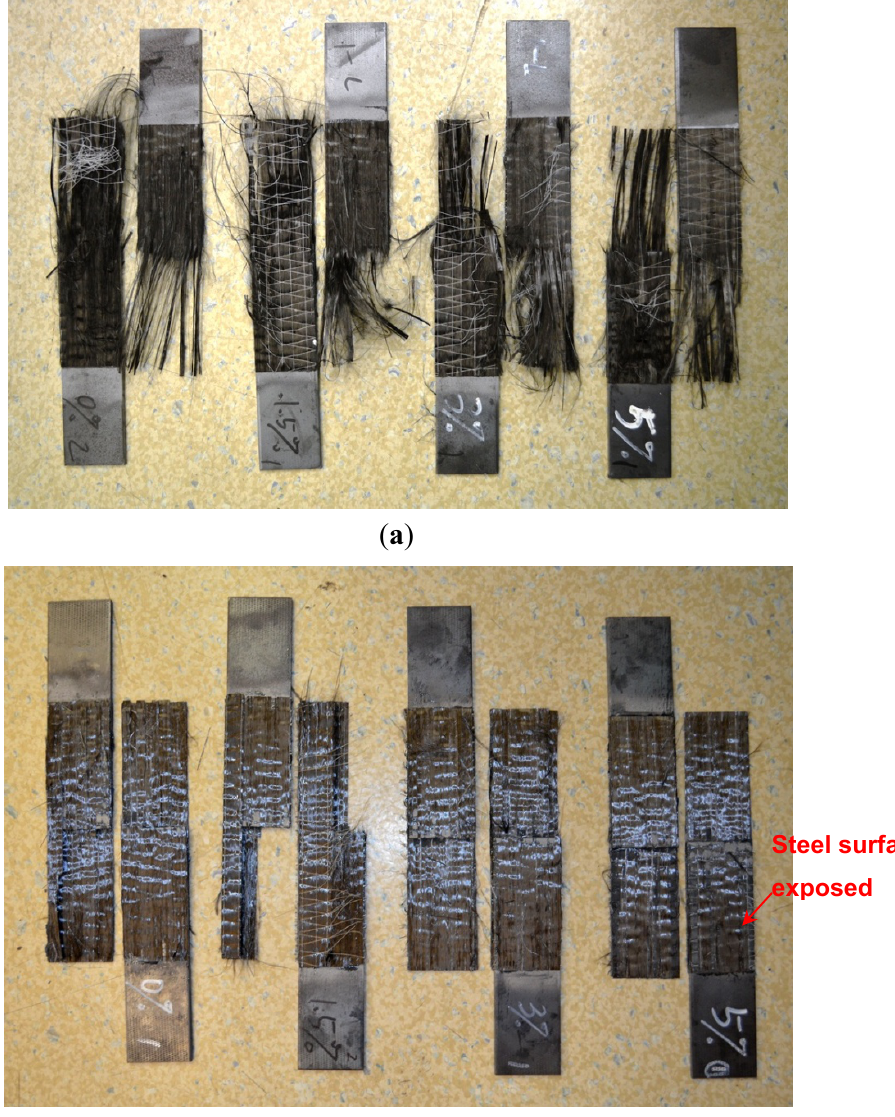
Figure 4. Failure modes of DJS specimens with ( a ) one layer of carbon fibre sheet (DJS0-1, DJS1.5-1, DJS3-1, and DJS5-1); and ( b ) three layers of carbon fibre sheet (DJS0-3, DJS1.5-3, DJS3-3, and